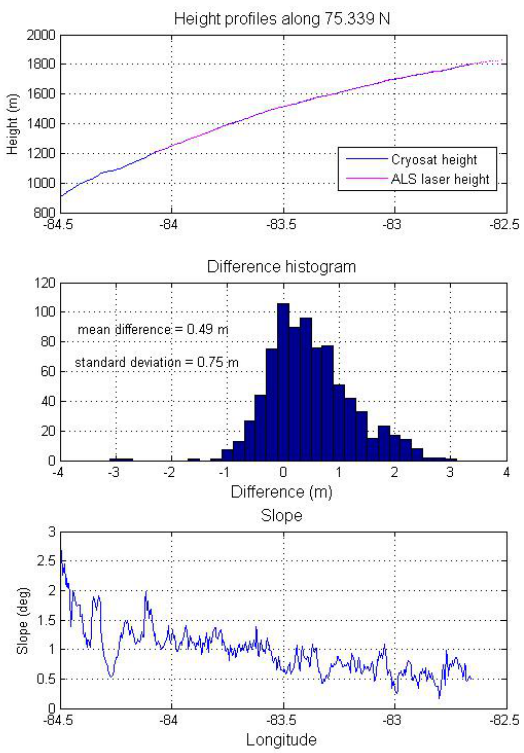
Fig. 9. The upper plot illustrates the E–W elevation at 73.339N for Figure 9. The upper plot illustrates the E-W elevation at 73.339 N for both the Cryosat DEM both the Cryosat DEM data and the ALS laser heights. The middle data and the ALS laser heights. The middle plot illustrates the histogram of the height plot illustrates the histogram of the height differences and the lower differences and the lower plot shows the E-W slope derived from the Cryosat results. plot shows the E–W slope derived from the Cryosat results.